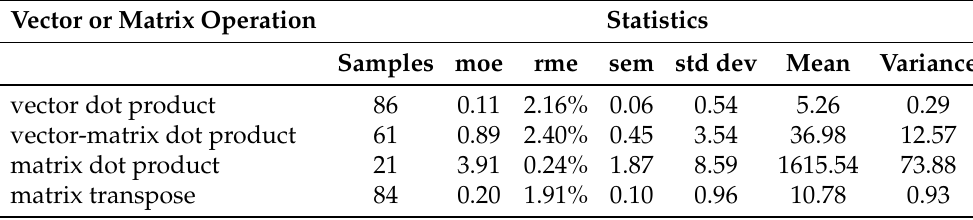
Table 24. Raspberry Pi IV benchmark statistics for vector and matrix operations with k = 64 (times in ms).